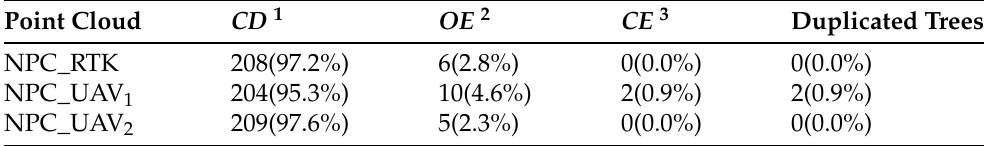
Figure 2. ( a ) Orthomosaic of the study area; ( b ) DTM generated from RTK measurements; ( c ) DTM generated from unsupervised classification of the point cloud; ( d ) DTM generated from supervised classification of the point cloud; and ( e – g ) Spatial distribution of differences between the DTMs. Table 3. Tree detection metrics for each normalized point cloud (NPC)